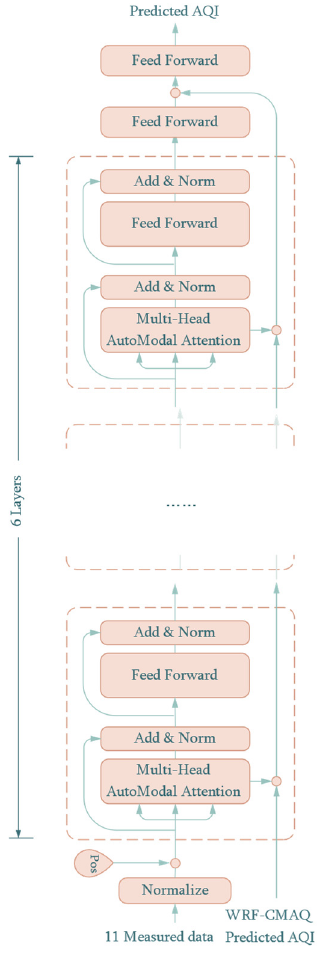
Figure 3. Prediction process of the auto-modal network.